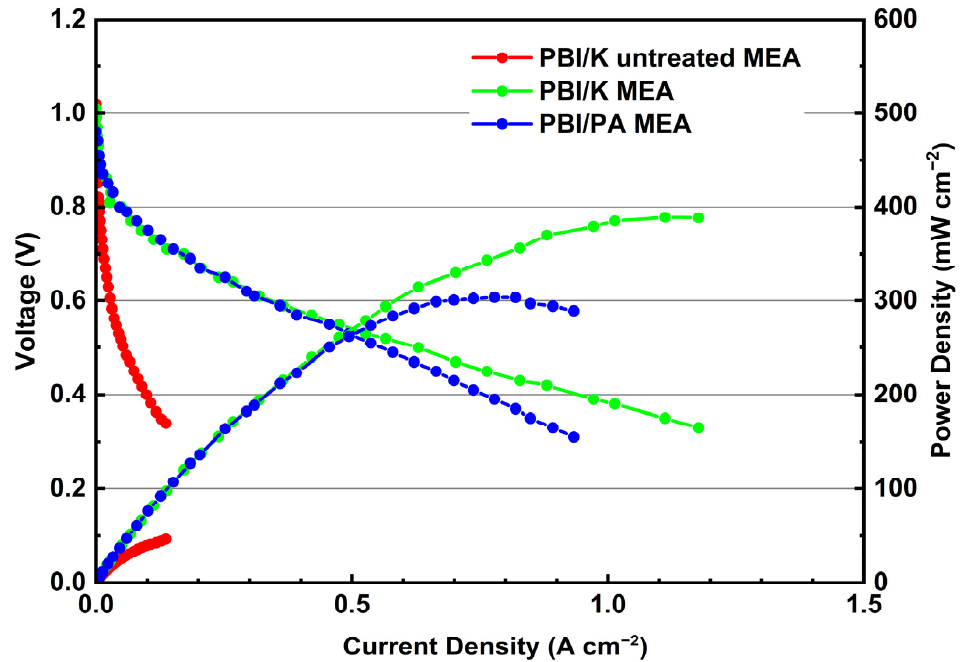
Figure 9. Polarization curves of treated and untreated PBI/K MEAs and PBI/PA MEA at 160 °C feed- ing with dry H 2 /O 2 (equal H 2 and O 2 flow rates at 0.4 L min − 1